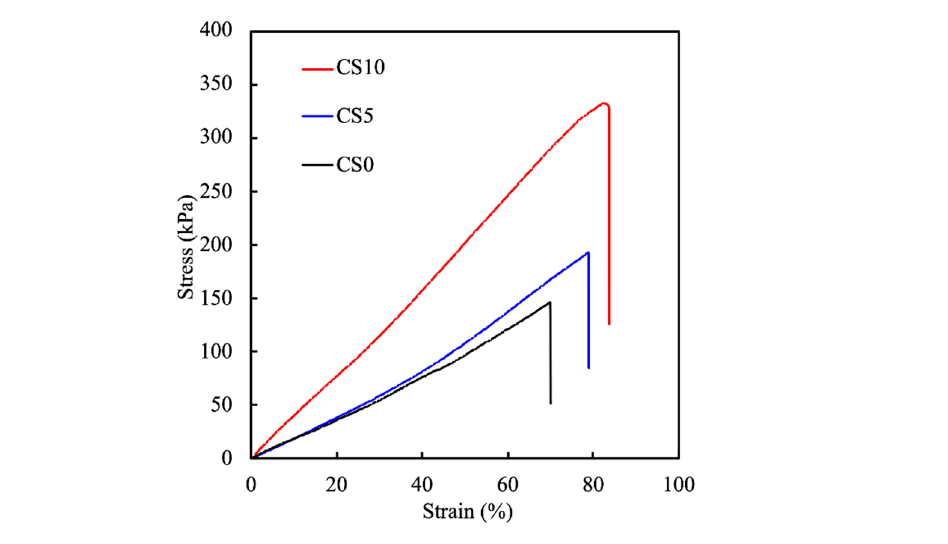
Figure 5. Stress–strain curves of the CS-contained GelMa scaffolds. Data presented as mean ± SEM, n = 6 for each group.